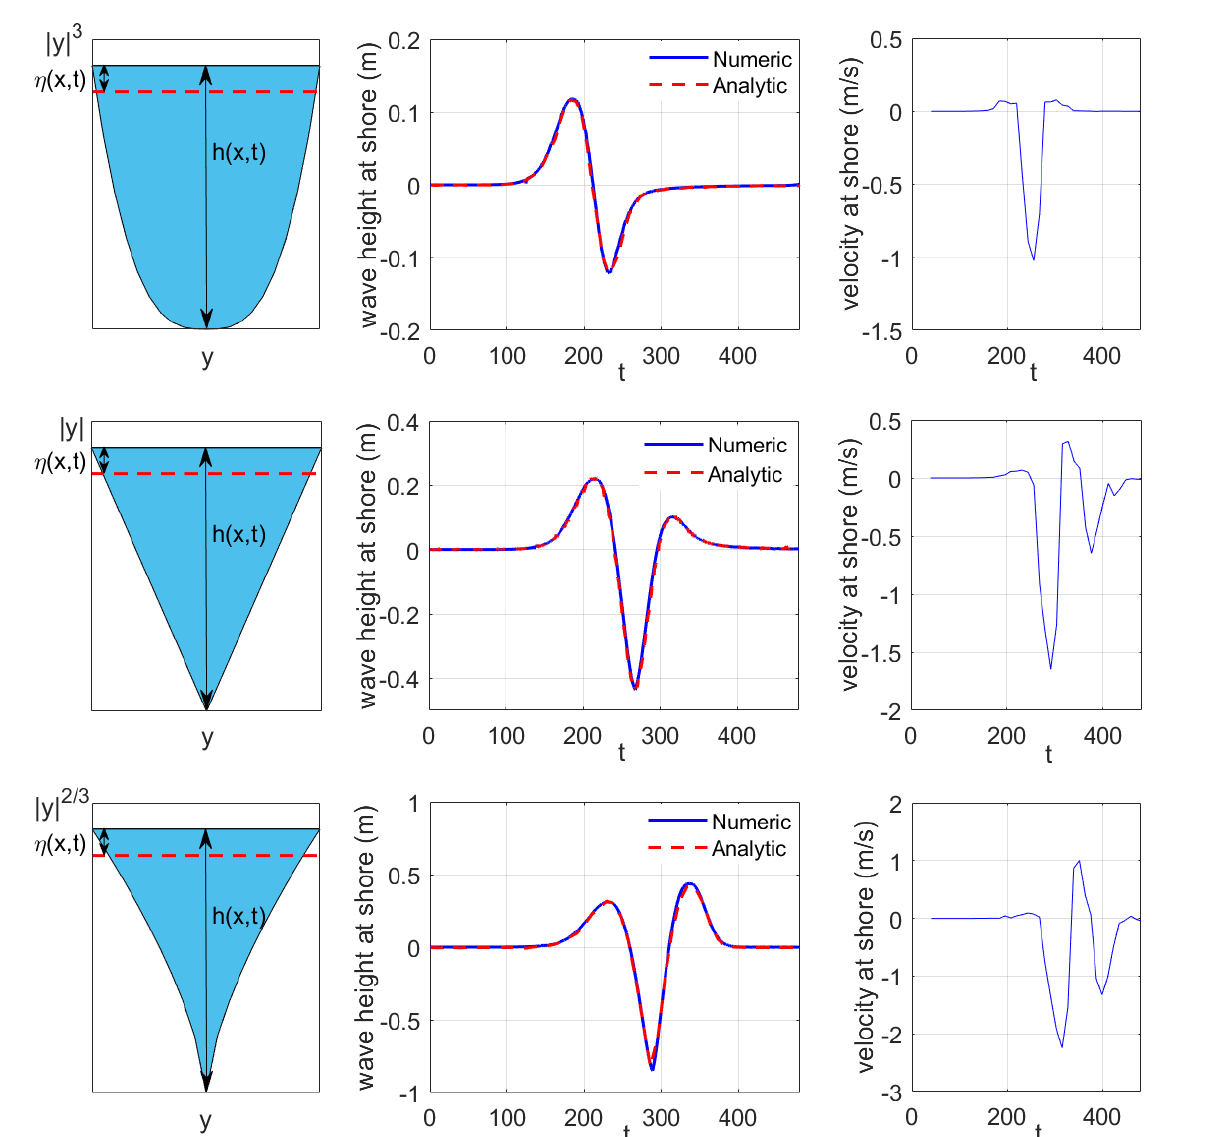
Figure 4. Numerical versus analytical shoreline for three different U-shaped bays for: m = 3 ( top ); m = 1 ( middle ); and m = 2/3 ( bottom ). The analytical shorelines are digitized from